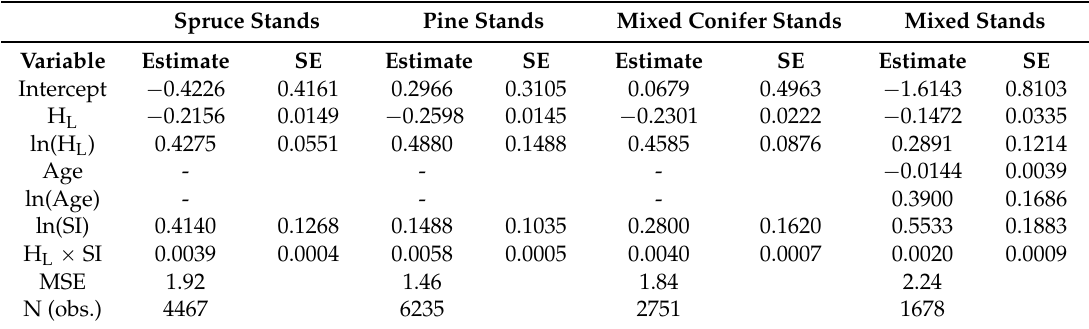
Table A2c. Coefficients for the basal area weighted mean height growth (H i , 5 years) functions.